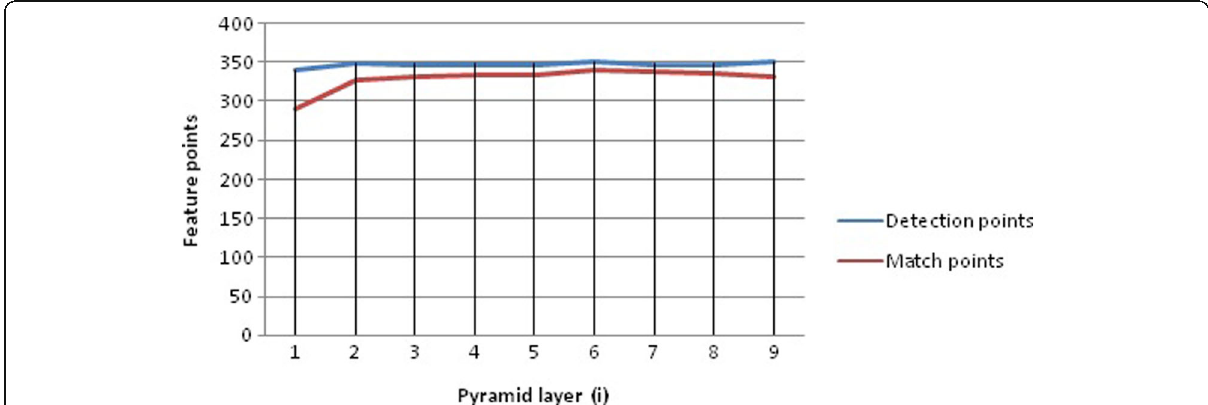
Fig. 17 Comparison of the number of feature points detected and the number of exact matches when the number of pyramid layers changes